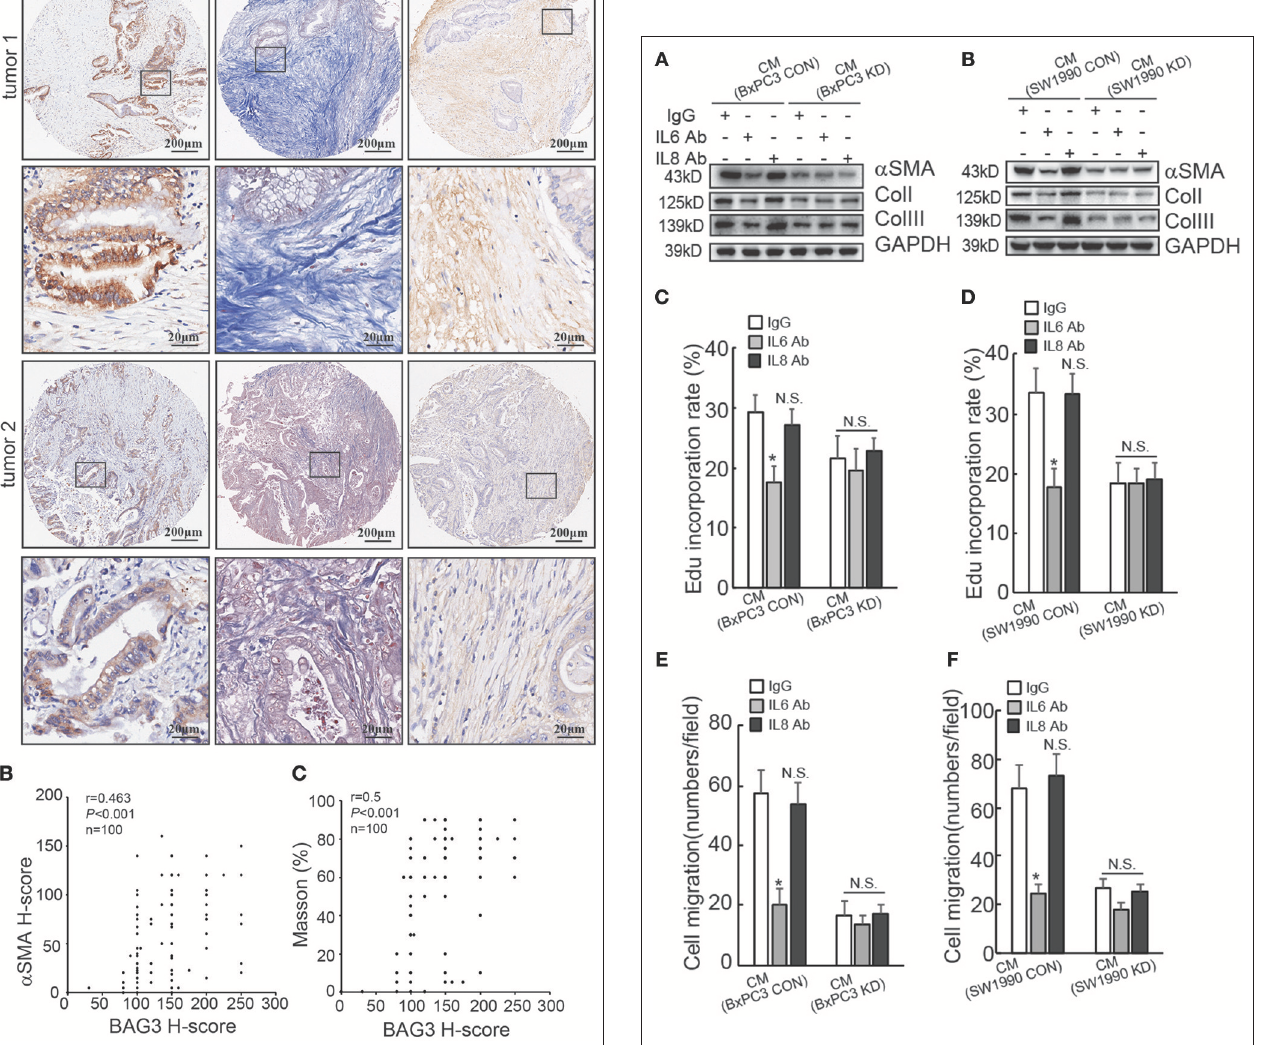
FIGURE 3 | Suppression of IL6 is implicated in suppression of PSCs activation by PDACs with BAG3 knockdown. (A–F) CM from PDACs were neutralized with the indicated antibodies, then was used to activate HPanSteC, α SMA, and collagen expression was analyzed using Western blot analysis (A,B) , DNA synthesis in the presence of CM from BxPC3 (C) or SW1990 (D) was analyzed using Edu incorporation, cell migration in the presence of CM from BxPC3 (E) or SW1990 (F) was analyzed using Transwell. * P <